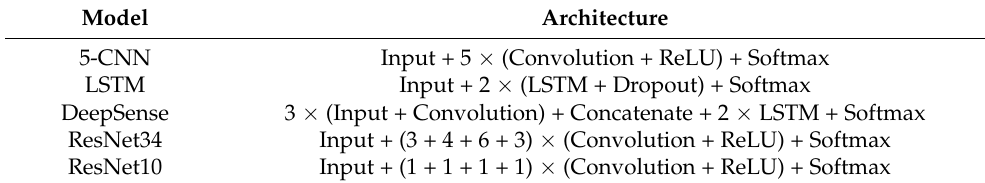
Table 3. The architecture of deep learning baseline models.